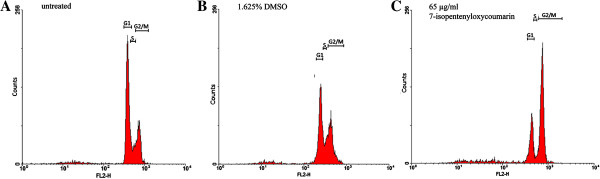
G2/M arrest of 5637 cells treated with 7-IP, 24 h after treatment. Cell cycle distribution of 5637 cells without any treatment (A). Cells treated with 1.625% DMSO (B) do not show remarkable changes in cell cycle phases. Cells treated with 65 μg/ml 7-IP (C) show a marked cell cycle arrest at G2/M stage, 24 h after treatment.